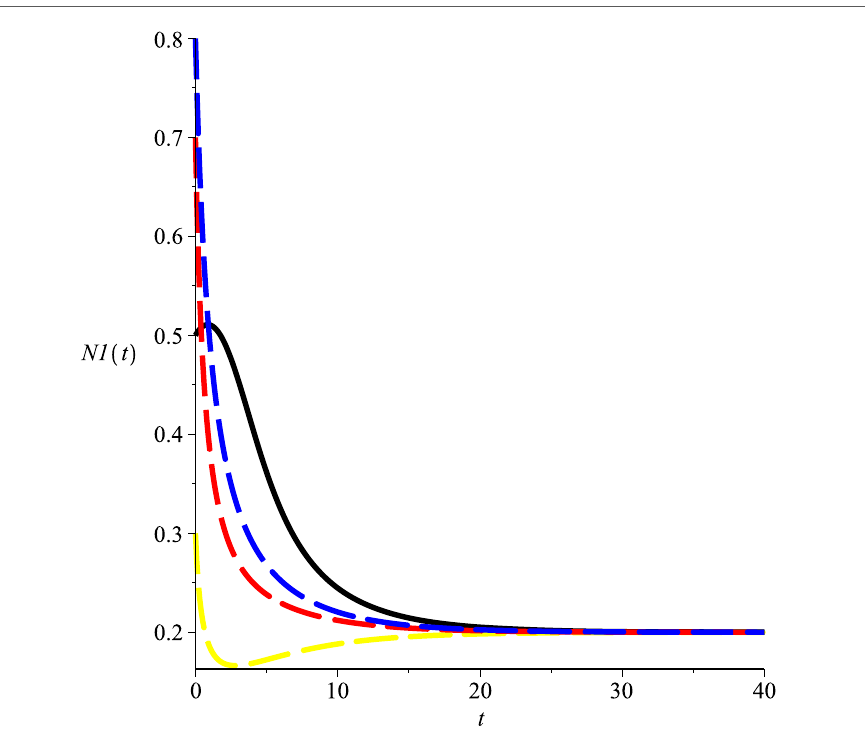
Figure 7 Numeric simulations of the first components of system (5.1) with m = 0.1, the initial conditions ( x (0), y (0)) = (0.5,0.1),(0.8,1),(0.3,3), and (0.7,2),